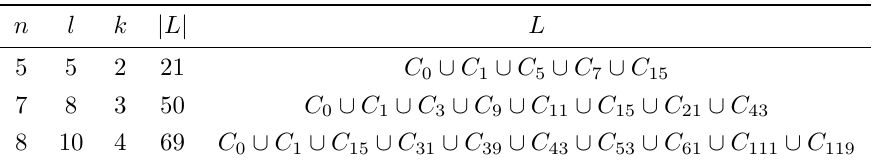
Table 5: New settings for parameters k and l of the CRV method.